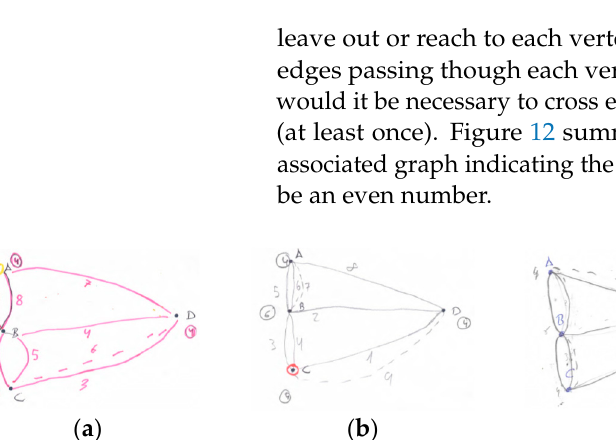
Figure 14. Chess routes. Drawing made by participant: ( a ) A5 using a rook; ( b ) A3 using a rook; ( c ) A7 using the queen; ( d ) A4 using a rook; ( e ) A6 using the king. Participants show good performance looking for patterns and apply them to solve the problem. Some of them also use symmetry as a problem-solving strategy. 3.7. Mathematical Challenges Challenges were created by participants working in groups. They start by brain- storming and then choose an idea as a challenge; they write it, solve it and finally they record a video with the question and another one with the answer. Proposals involving graph theory are collected in Table 4.